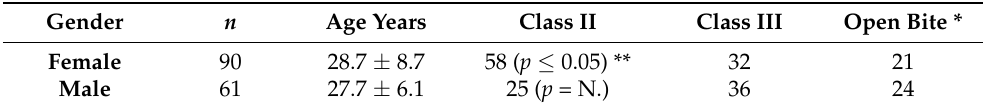
Table 1. Characteristics of the study